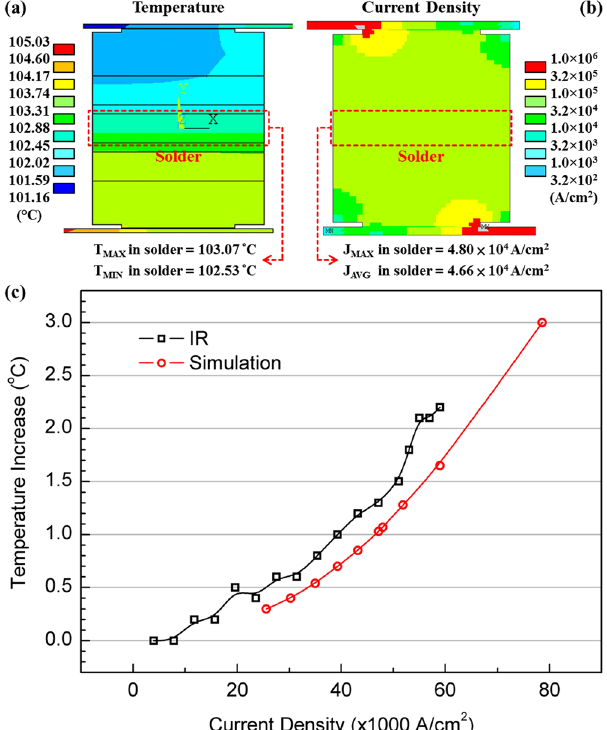
Figure 3. The simulated ( a ) distribution of temperature and ( b ) distribution of current density in the 18 µ m microbump; ( c ) Plot of solder temperature against applied current density obtained from the simulation and infrared microscopy